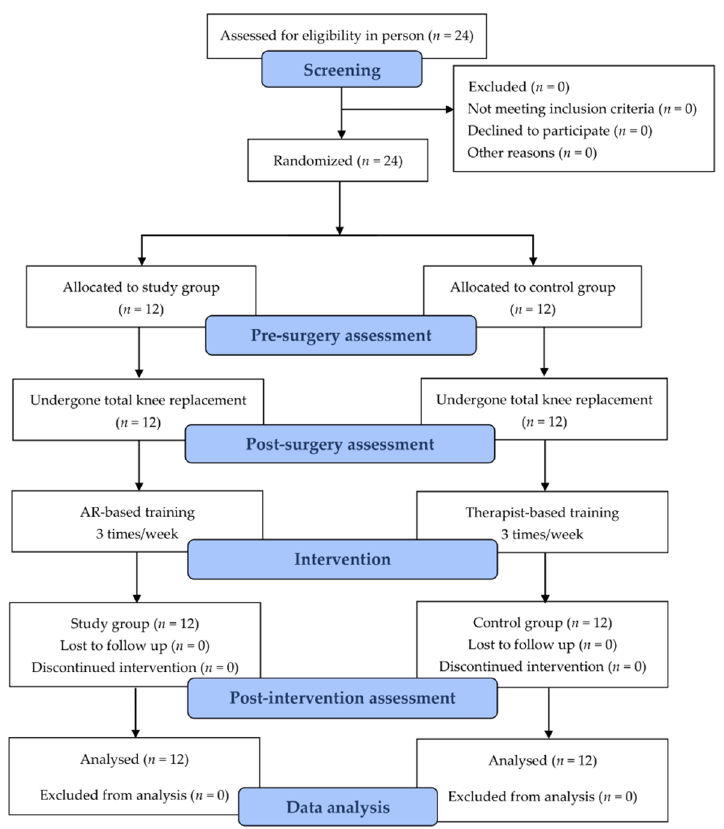
Figure 1. Study flow